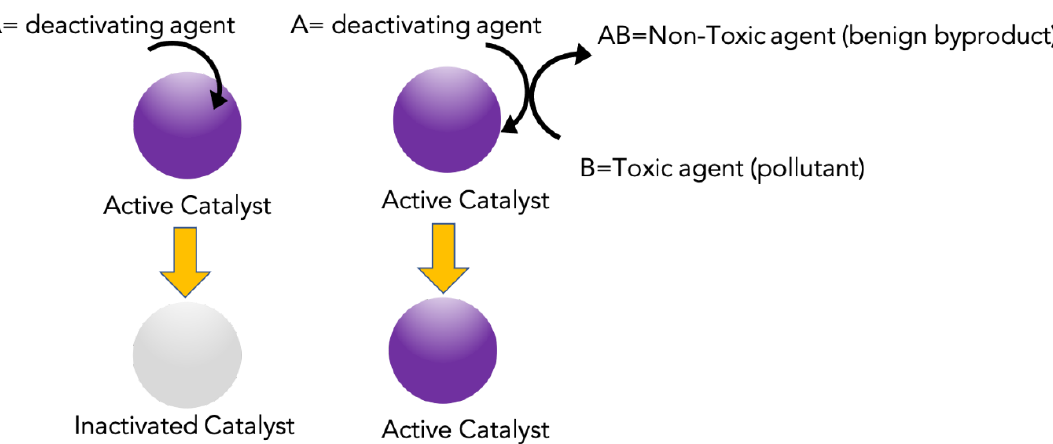
Figure 4. Scheme representing the use of toxic or unwanted reagents/byproducts to prevent catalyst’s deactivation. See [43] for details.